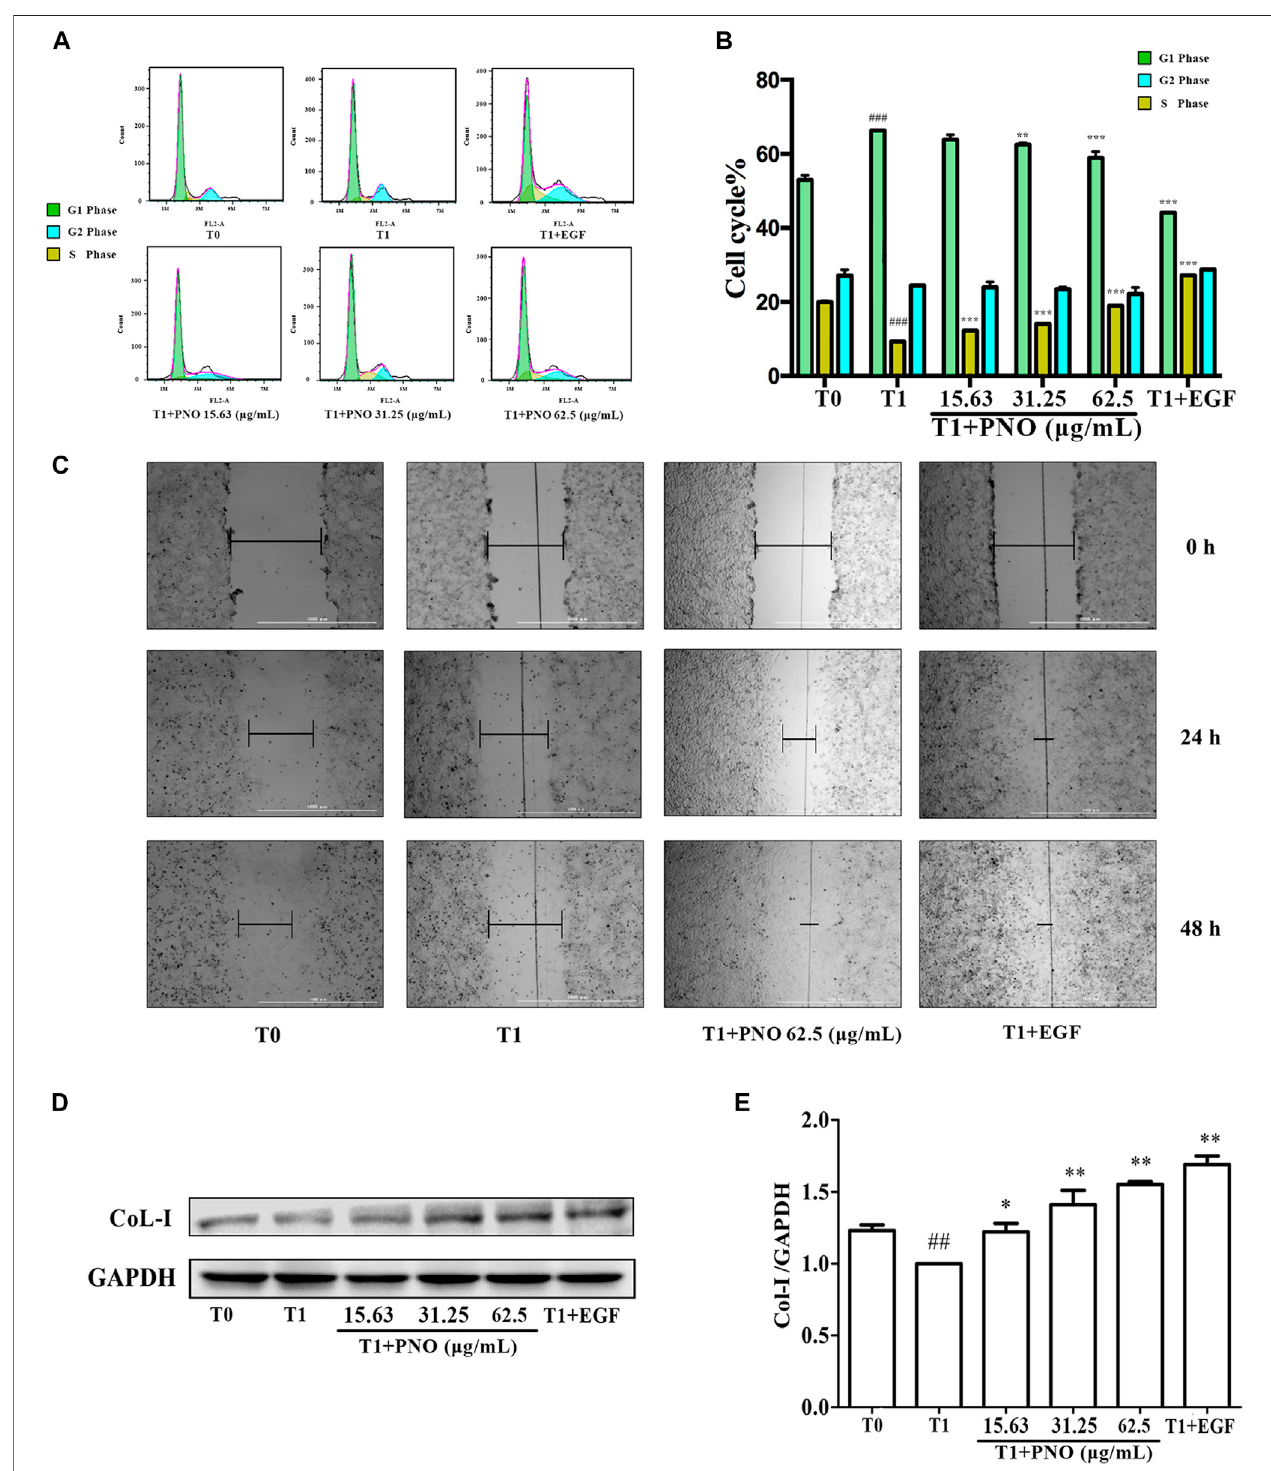
FIGURE4| EffectofPNOoncellcycleprogressionandmigrationofreplicativesenescentNIH-3T3cells. (A , B) FlowcytometrydeterminedtheeffectofPNOonthe cell cycleofreplicatingsenescent NIH-3T3 cells. (C) Theeffect ofPNO onmigrationofreplication senescence NIH-3T3 cells. (D , E) Effect ofPNO onexpression ofCoL-I proteins by replicative senescent NIH-3T3 cells as detected by western blotting (WB). # indicates a signi fi cant different relative to T0 group. ## p < 0.01, ### p < 0.001. * Indicates a signi fi cant different relative to T1 group. * p < 0.05, ** p < 0.01, *** p < 0.001.